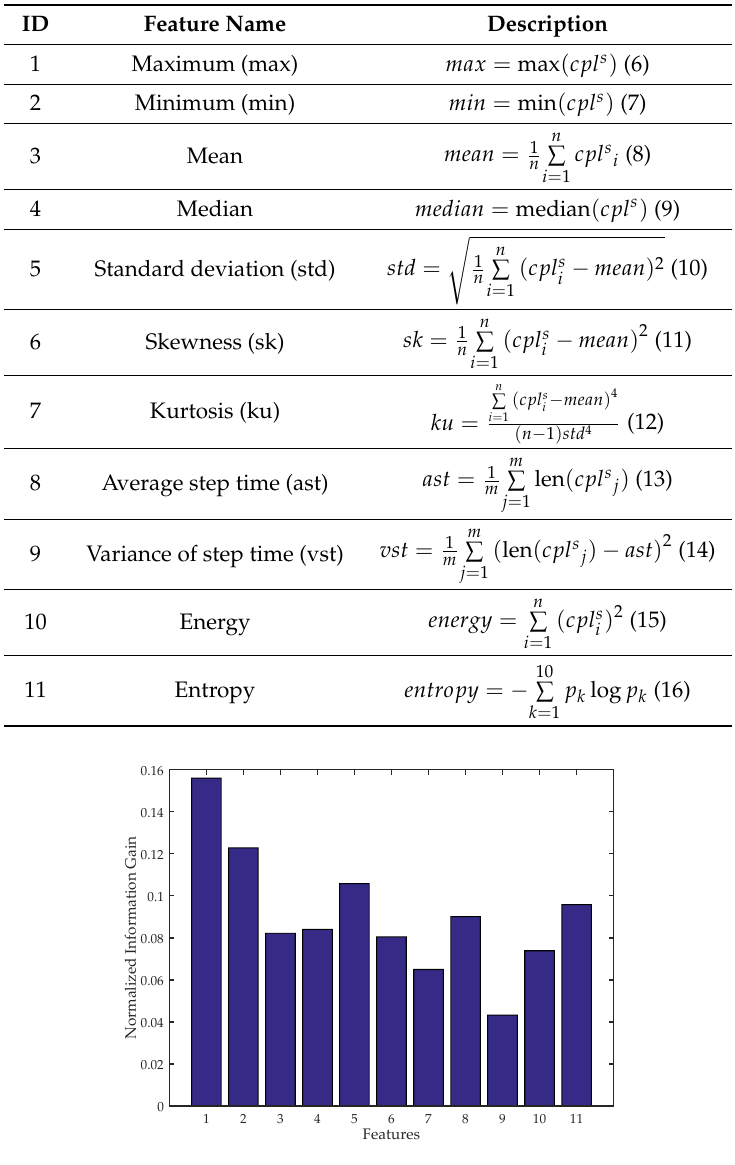
Figure 5. Normalized information gain of the candidate features.